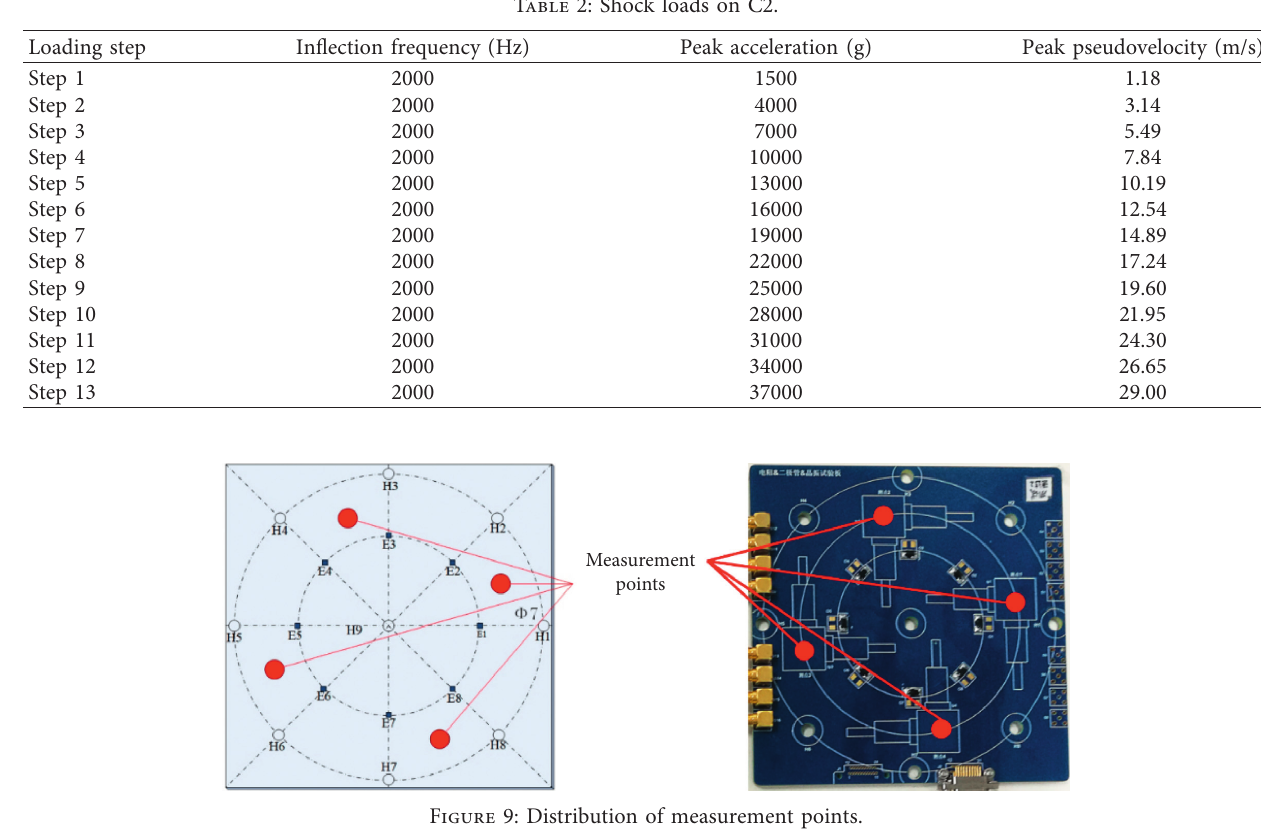
Table 2: Shock loads on C2.